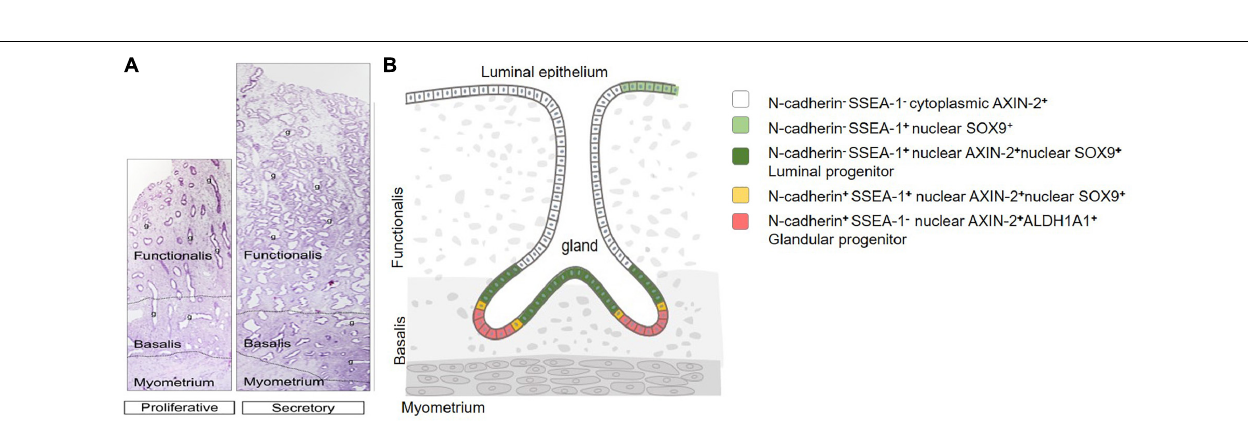
FIGURE 2 | Human endometrial epithelial location and hierarchy. (A) Full-thickness proliferative and secretory stage premenopausal endometrium. Functionalis and basalis delineated by dotted line. Glands (g) extend from the luminal epithelium to the endometrial-myometrial junction, showing branching and horizontal gland profiles in the deep basalis. (B) Epithelial stem/progenitor hierarchy. Adapted with permission from Gargett et al. (2012) and Filby et al. (2020).